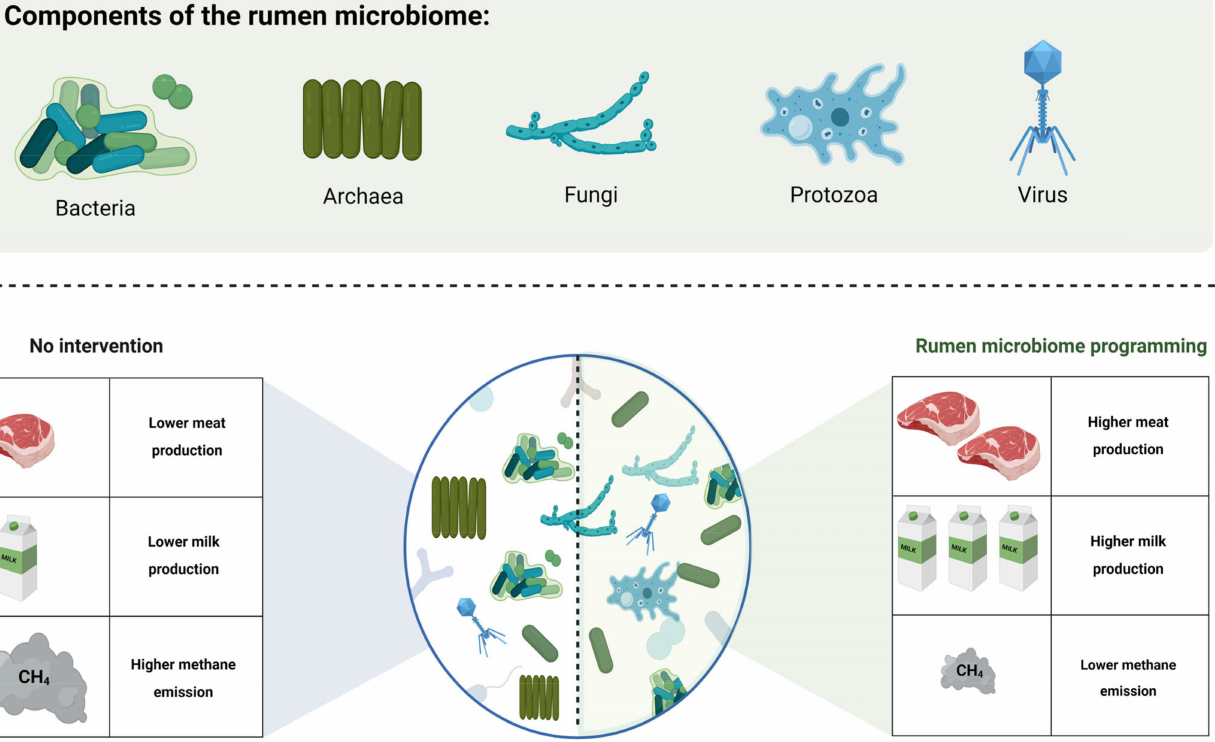
Figure 1. ( A ) Components of the rumen microbiome: bacteria, archaea, fungi, protozoa, and virus. ( B ) Improvement in the milk and meat production and reduction in methane emission through rumen microbiome